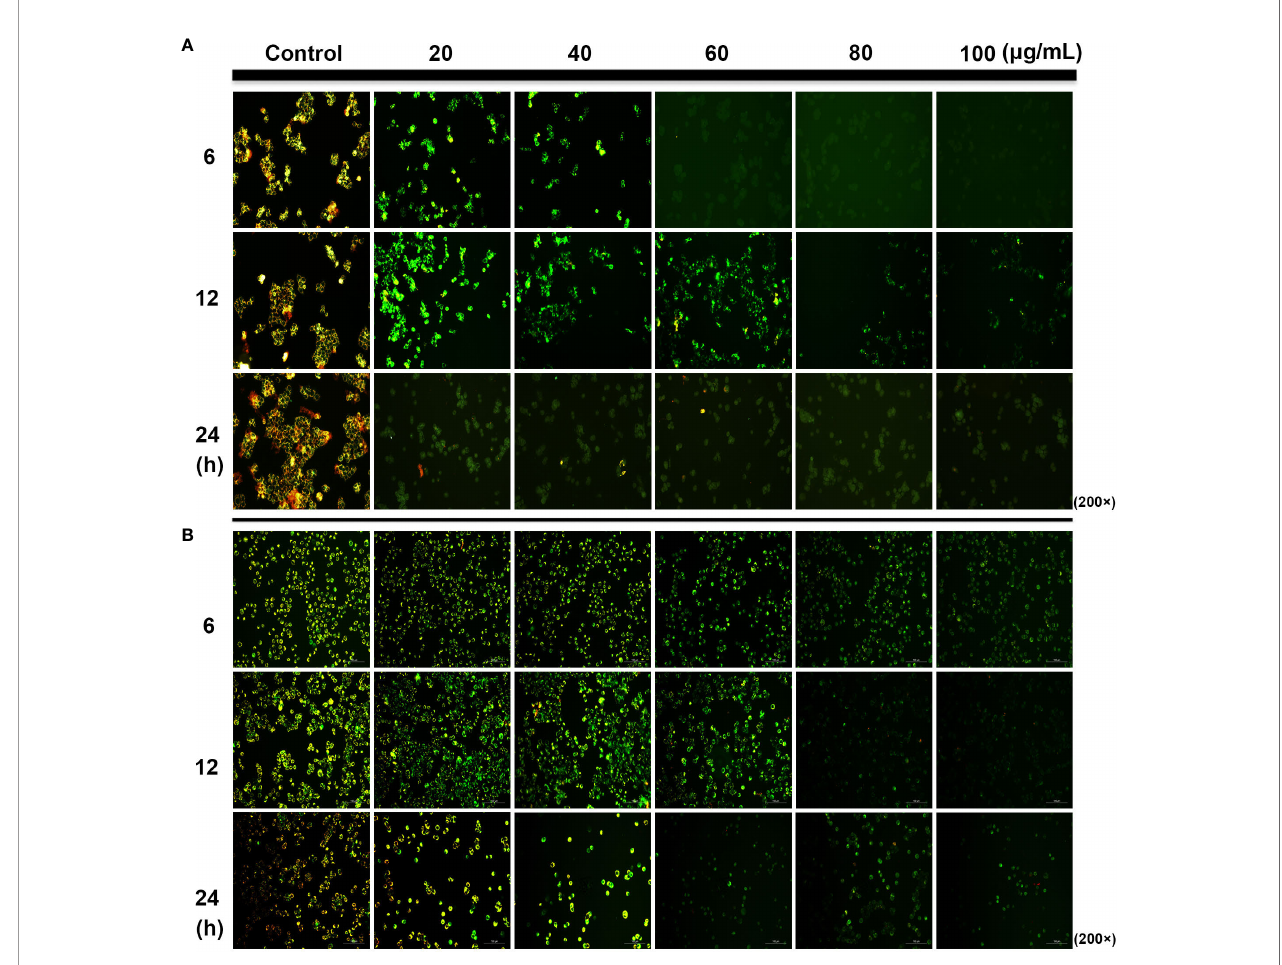
FIGURE 3 | Change in the mitochondrial membrane potential of HCT116 (A) and HT29 (B) cells treated with different SDEA concentrations at different